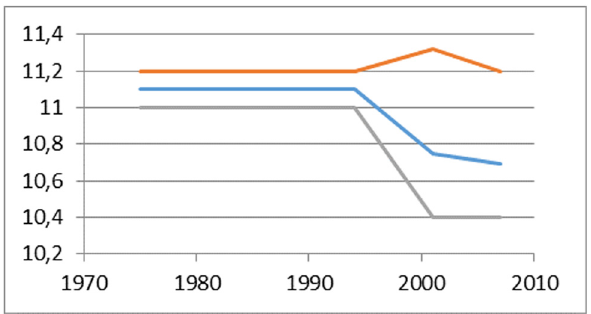
Figure 16: The progress of corrosion during the use of tank number 2 inventoried by the authors for the fi rst coating sheet ( maximum, average, and minimum values are compared here for illustrative purposes ) .